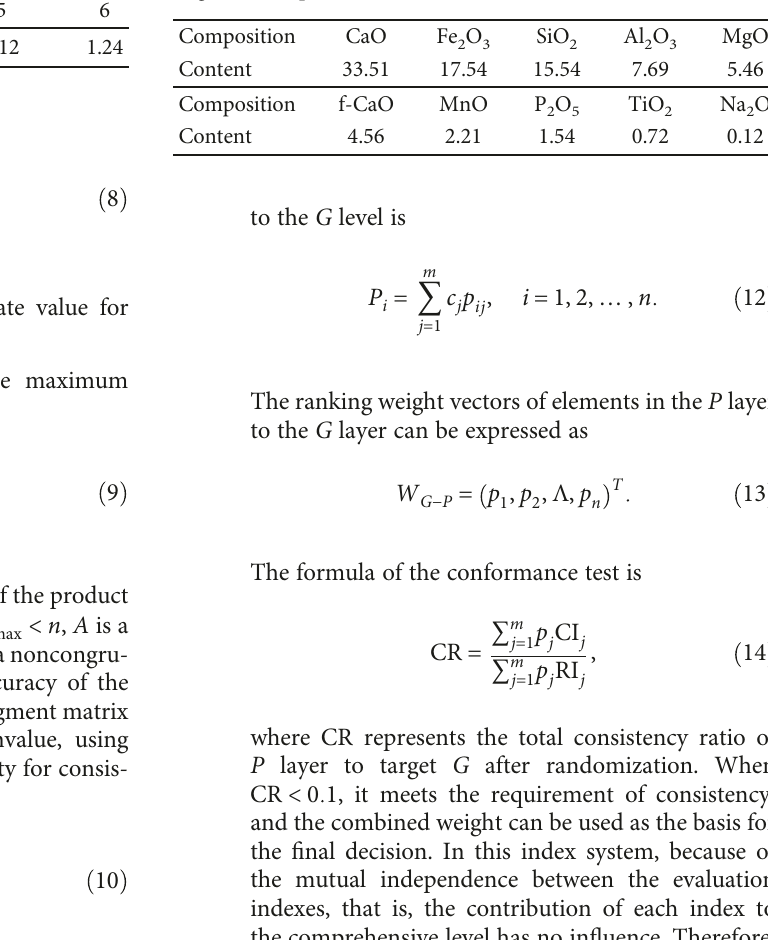
Table 3: Reference values for random consistency indexes. Table 4: Predicted value of the major chemical composition of steel slag in a steel plant in Hebei